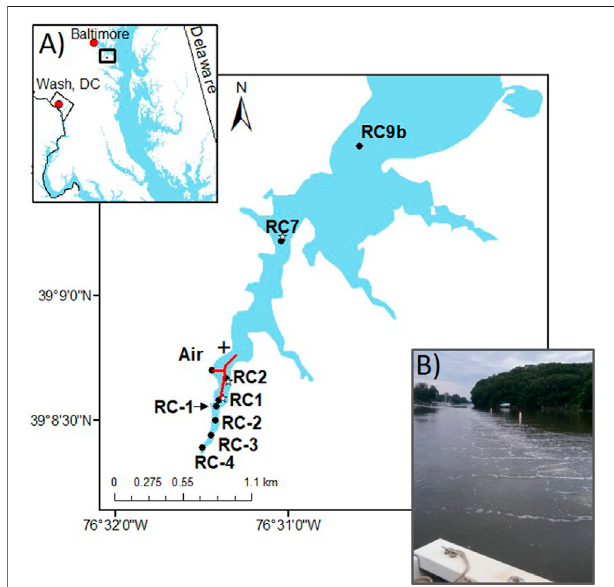
FIGURE 2 | Sample location map for Rock Creek. Red lines show location of the aeration tubes, black dots are water column and sediment station locations, white stars are OsmoSampler locations (very close to black dots), and black cross is location of dock where the benthic lander was deployed. (A) Location of Rock Creek (black square) in the northern ChesapeakeBaynearBaltimore,Maryland. (B) Photoofbubblesbreakingthe surface in 2019 (photo by Laura